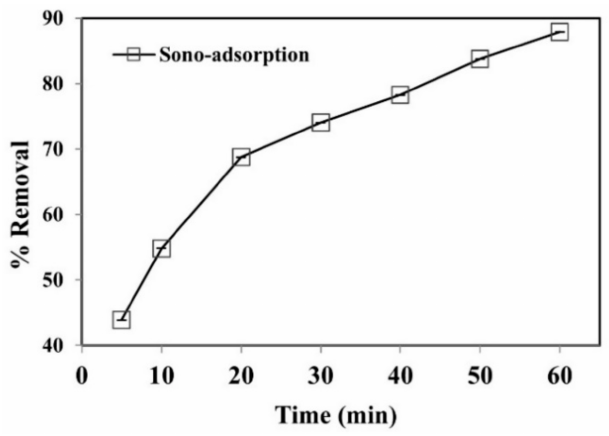
Figure 8. Removal of phenol using sono-adsorption by WGTLs. Reaction conditions: time = 60 min, phenol conc. = 25 mg L − 1 , pH = 3.5, adsorbent dose = 800 mg L − 1 , cavitation power = 80 W, temperature = 30 ± 2 ◦ C.